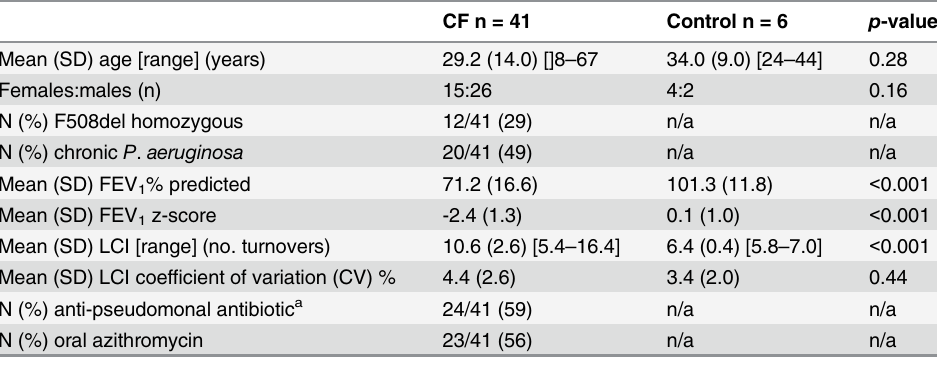
Table 1. CF patient and healthy control subject